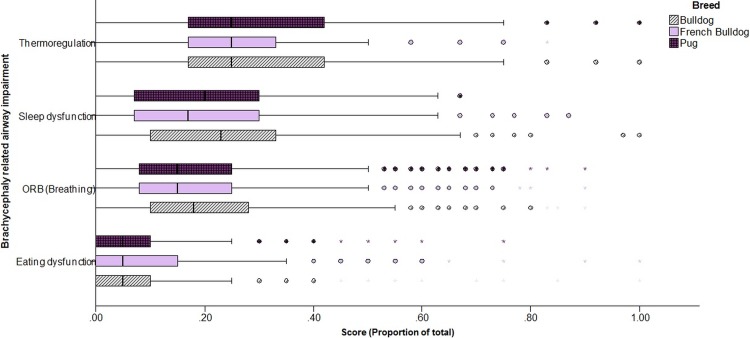
Severity of airway impairments in a population of Bulldogs, French Bulldogs and Pugs.N.B. Scores for each scale are expressed as a proportion of the maximum possible score to standardise across scales.